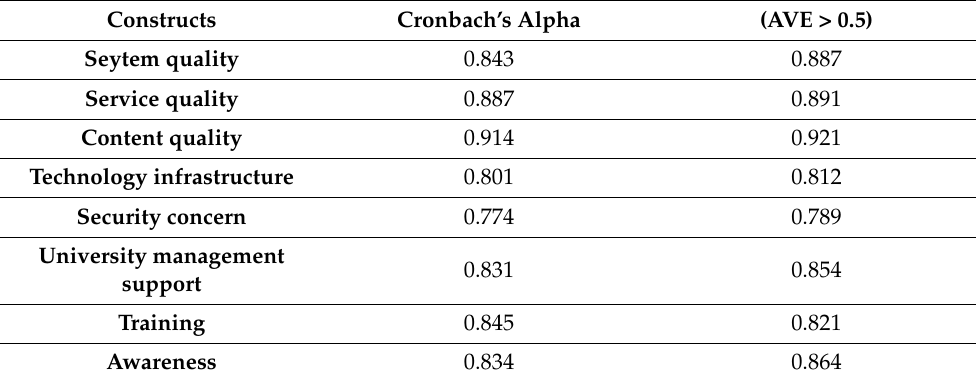
Table 1. Reliability and convergent validity analysis.